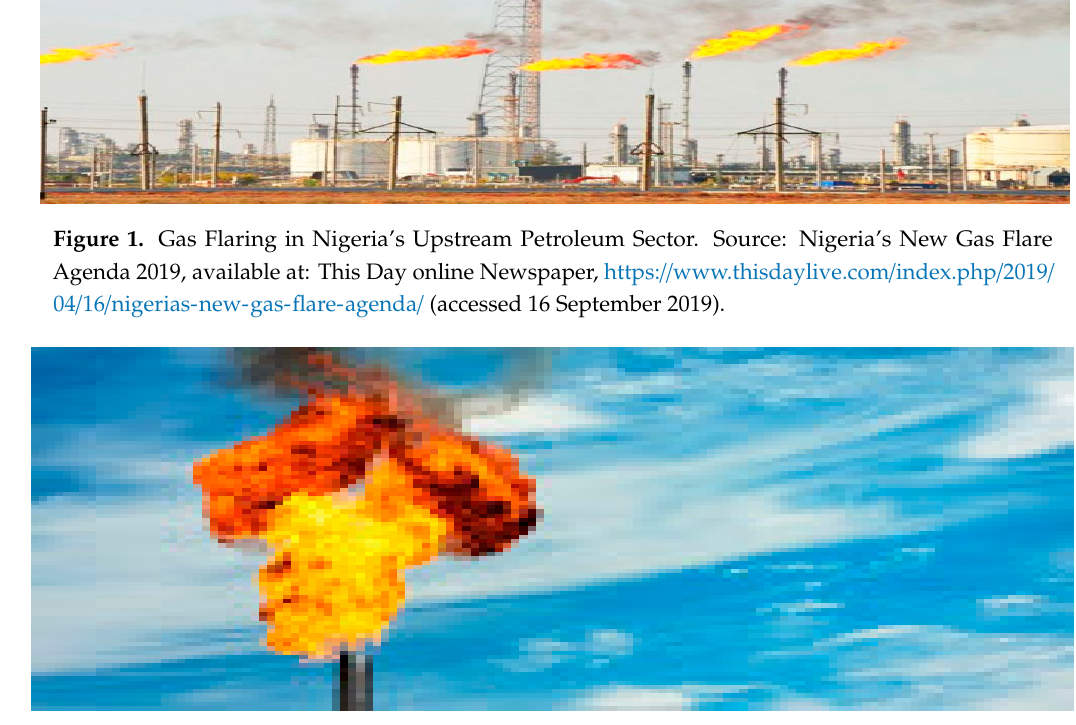
Figure 2. Gas Flaring in Nigeria’s Upstream Petroleum Sector. Source: NNPC Sets 2020 Target to End Gas Flaring, available at: http://www.epiczone.com.ng/nnpc-sets-2020-target-end-gas-flaring/amp/ (accessed 16 September 2019).